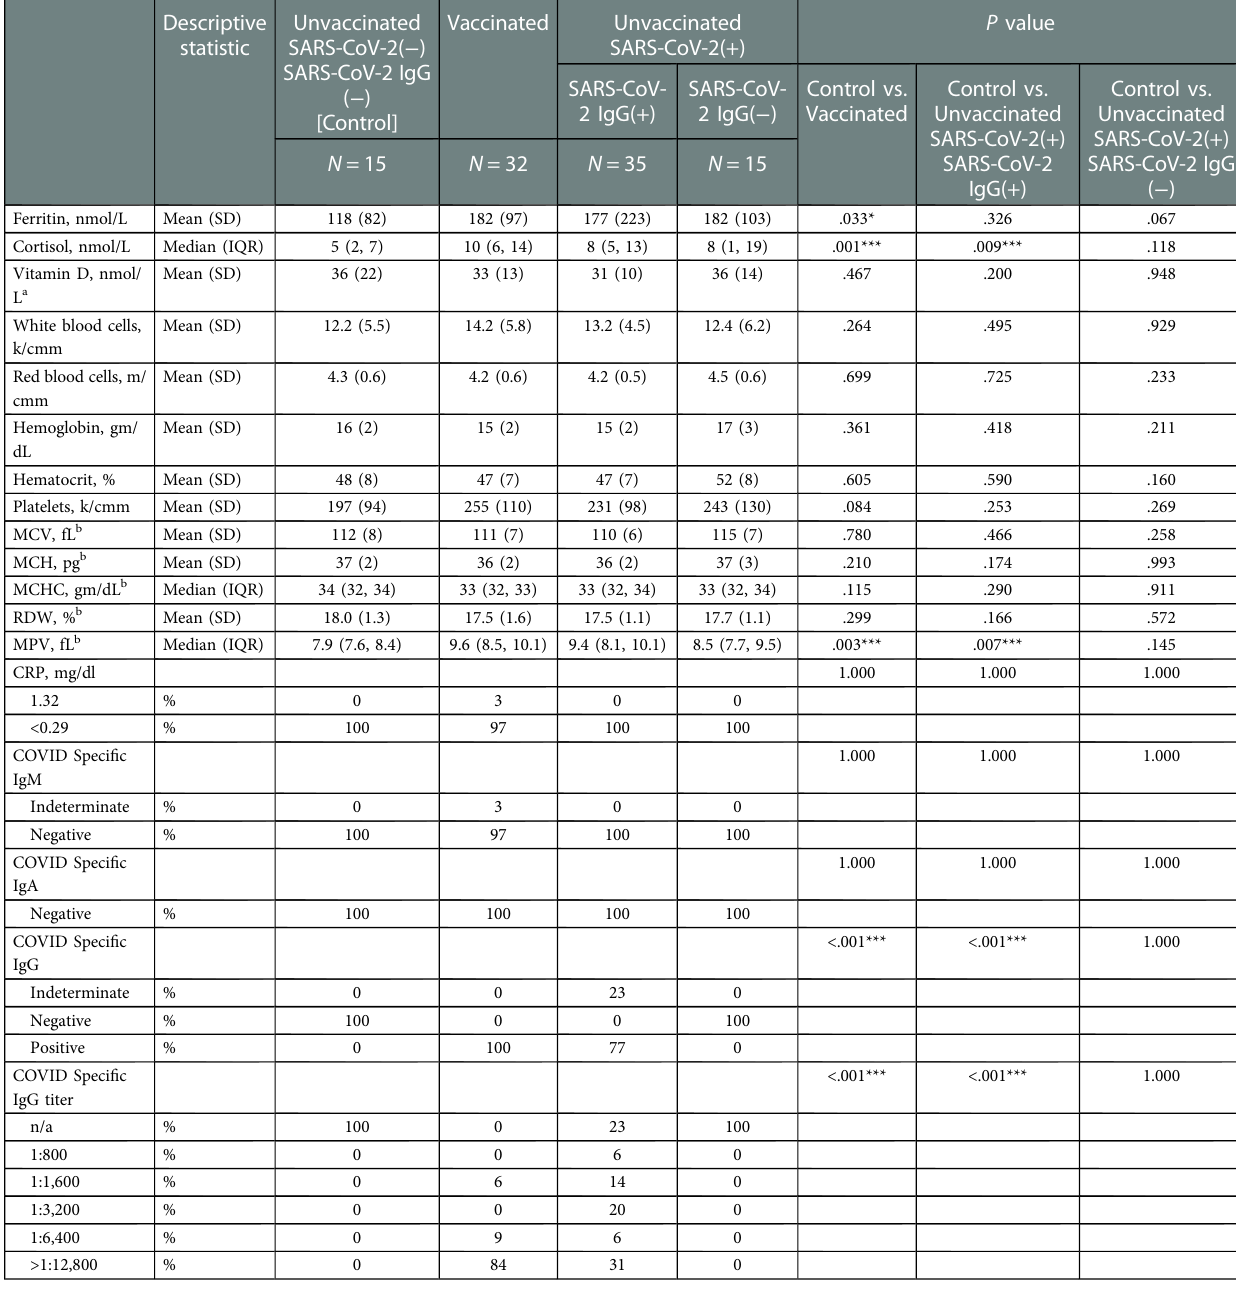
TABLE 4 Infant in fl ammatory & anti-in fl ammatory markers, and immunological titers strati fi ed by study groups based on SARS-CoV2 exposure/ vaccination and presence of neonatal SARS-Cov2 speci fi c IgG, N =97. Descriptive